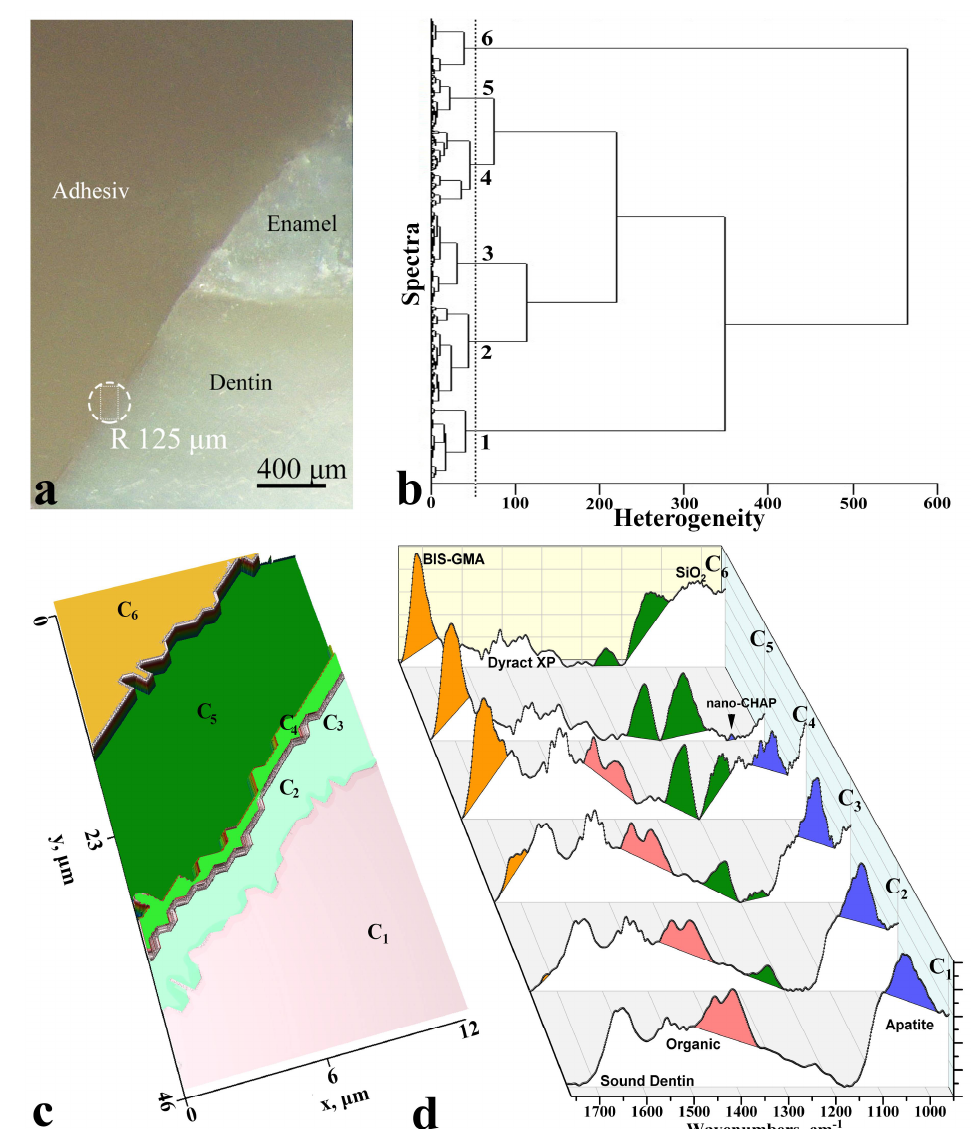
Figure 1. The use of multivariate analysis of synchrotron ATR-FTIR chemical imaging spectral data and its 2D visualisation for the diagnostics of biomimetic sound dentin/dental composite interface for the typical sample. ( a )-optical images of interface area, ( b )-dendrogram of heterogeneity, ( c ) colour coding of the cluster analysis results, ( d )-the averaged FTIR-spectra of each cluster.